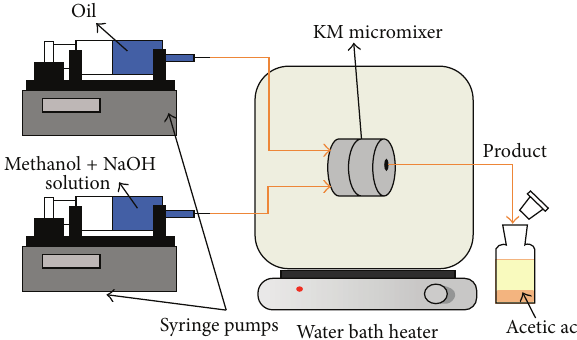
Figure 1: Schematic view of the KM mixer